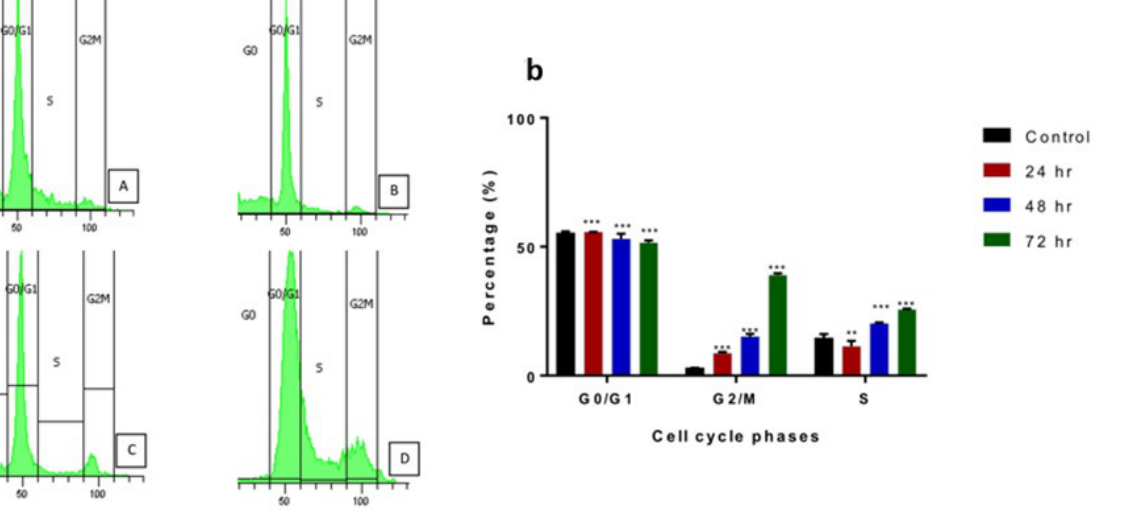
Figure 7 . ( a ) represents the proportions of PC-3 cells upon treatment with GMG-ITC based on a time-dependent manner. The proportions of 24 h (B), 48 h (C), and 72 h (D) compared with untreated cells (A), which acts as the control in this experiment. ( b ) represents cell cycle analyses for 24, 48, and 72 h. Data are expressed as *** p < 0.0001, ** p < 0.005 when compared with the control.